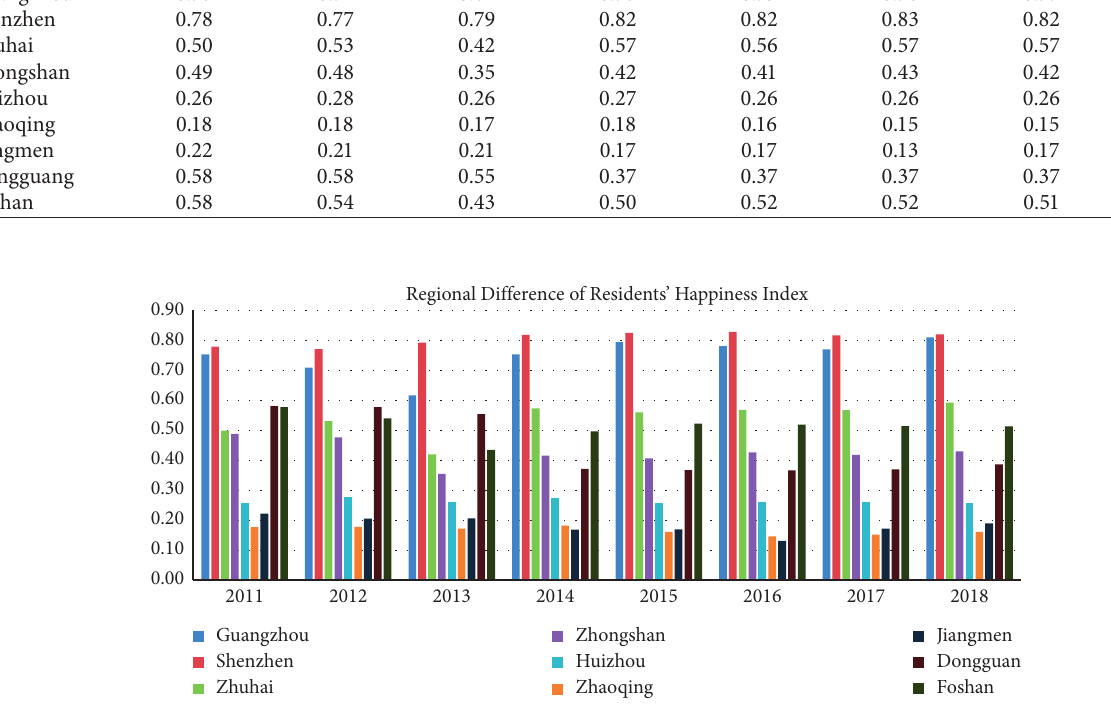
Figure 3: Regional differentiation of the happiness comprehensive index of the Pearl River Delta residents.